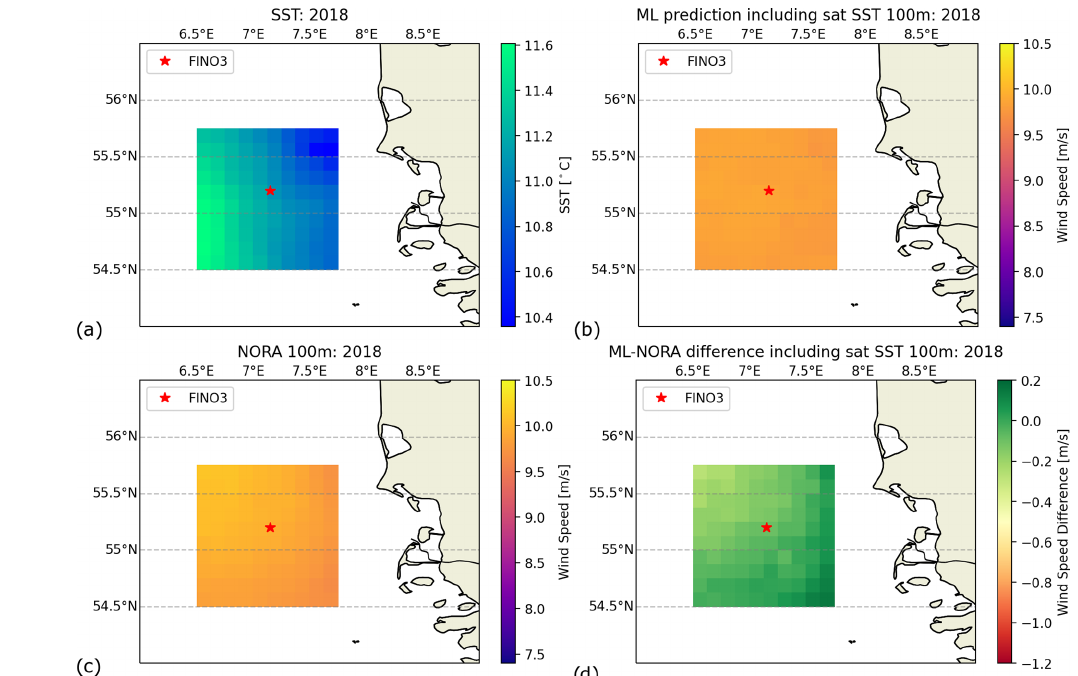
Figure 5. (a) Mean SST for 2018 regridded to the ASCAT WVCs. (b) RFM-predicted wind field at 101m with varying SST. (c) Mean NORA3 wind speeds at 100m collocated and regridded to the ASCAT WVCs. (d) Wind speed difference between (b) and (c) .